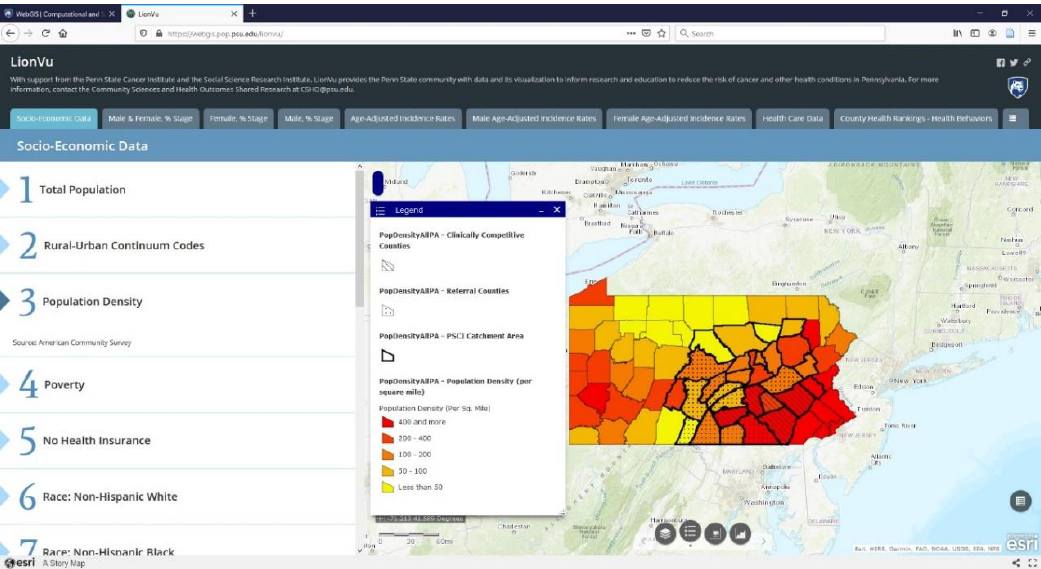
Figure 1. Original Design of LionVu 1.0 for population density (per square miles) within Pennsylvania. The 28 county Catchment Area is outlines in a thick black line.